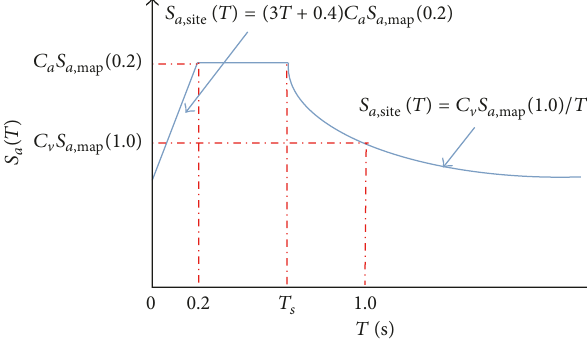
Figure 2: ISO seismic design